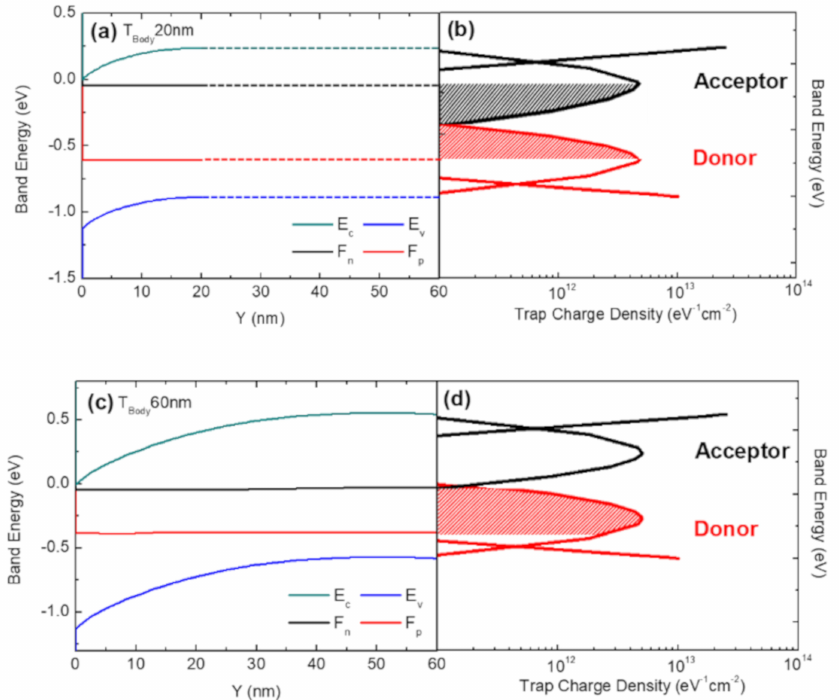
Figure 8. ( a ) Energy band in a vertical cut and ( b ) trap charge densities of TBody20 nm. Moreover, TBody60 nm’s ( c ) energy band and ( d ) trap charge densities during the read operation after 10 ns of hold time when the Write“1” operating drain voltage is 1.0 V. The dashed lines in ( c ) are the connection of the band energy from the 20 nm point. The black and red shaded regions in ( c ) and ( d ) represent energy levels capable of trapping electrons and holes,